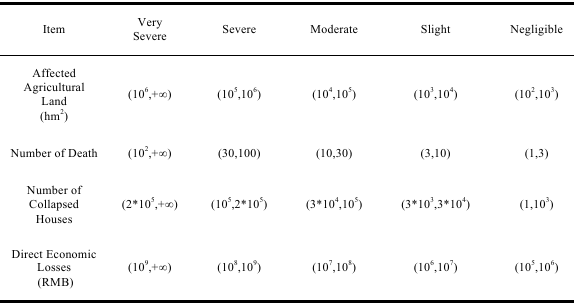
Table 1. Graded standard of single disaster item in China Second, by using the theory of grey association analysis (Yang, 1997; Wang et al. 2014; Fu, 1992), the association degree can be calculated and the general disaster level can be confined. The primary data and assessed results are summarized in Table 2. And the grading results covers all degree classes. Table 2. The tropical cyclone damage and general disaster